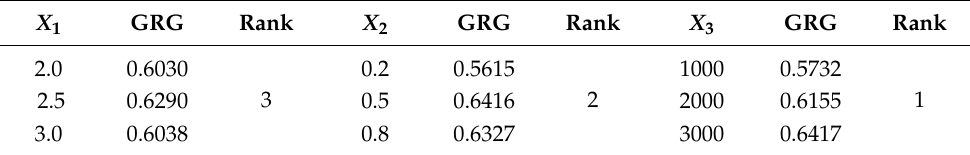
Table 10. Main effects of considered parameters on mean GRG values.